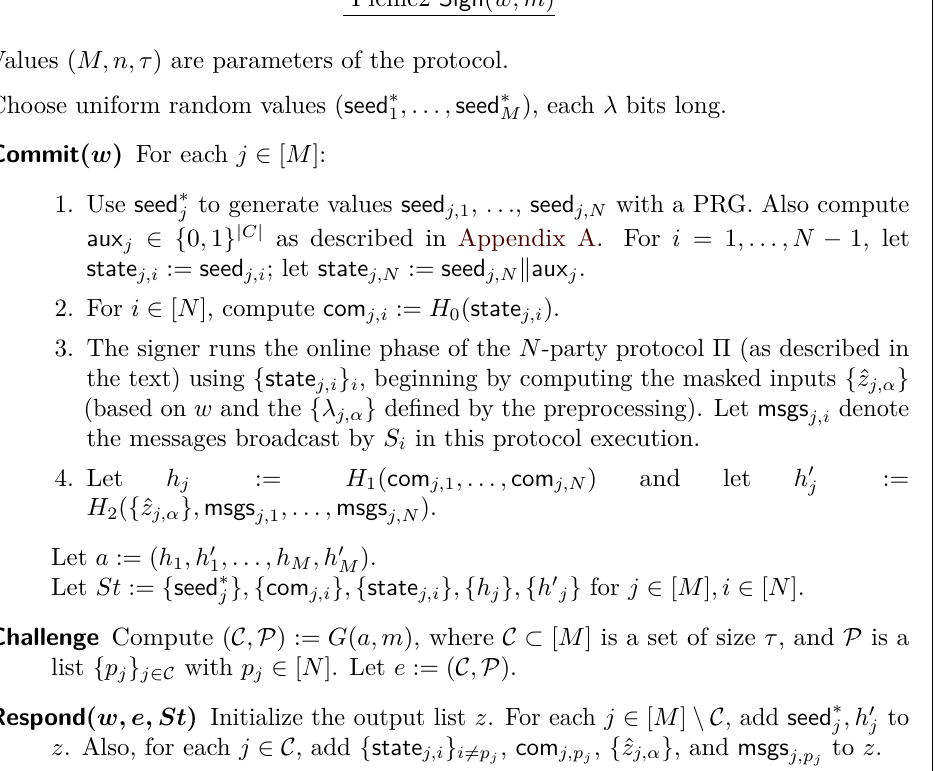
Picnic2 Verification Verify ( σ, m )